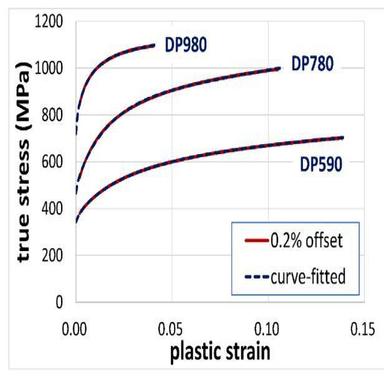
Comparison of the true stress-plastic strain curves between 0.2% offset method and curve-fitted.